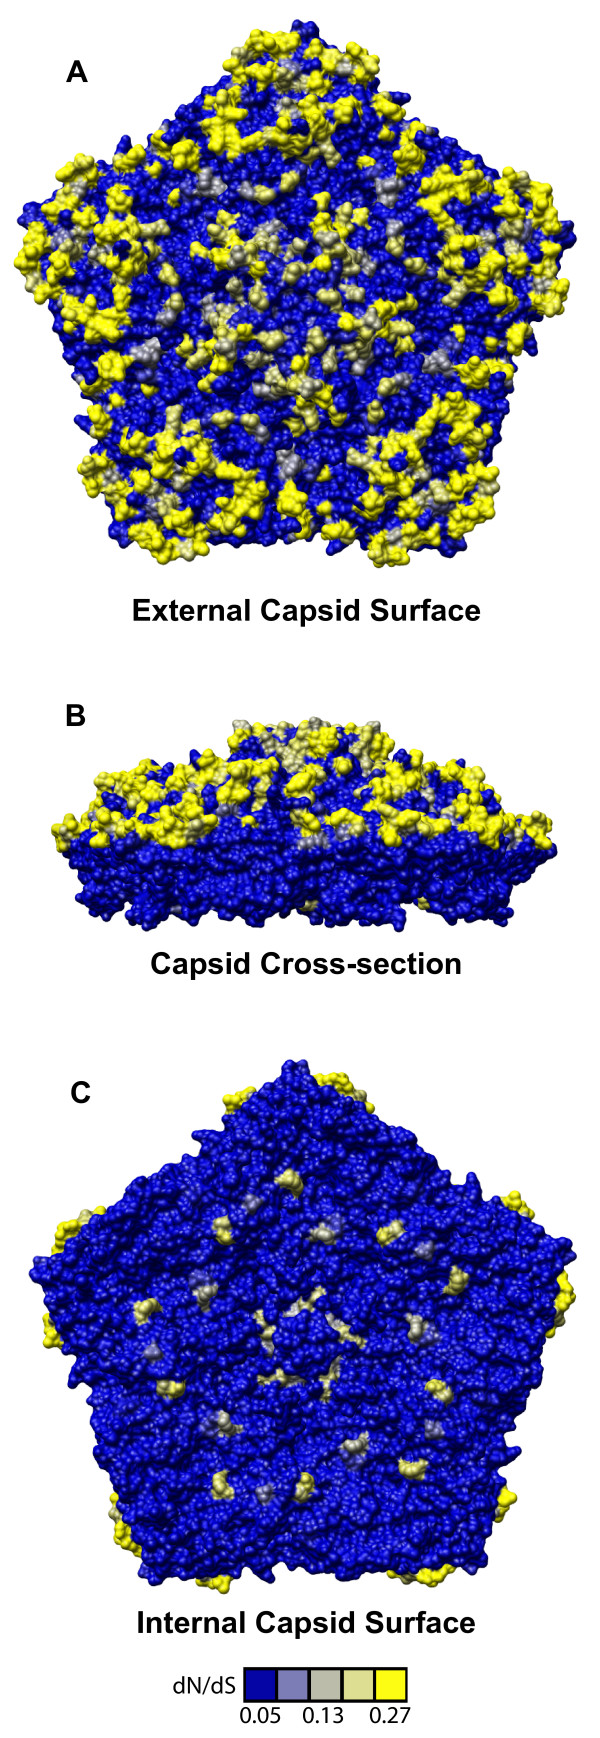
Distribution of selective pressure on the HRV capsid pentamer subunit. Capsid pentamer subunit from the HRV16 viral particle crystal structure (Hadfield, et al., 1997) with residues shaded in yellow according to their corresponding dN/dS values (scale bar below panel C). A. External view. B. Cross-sectional (inside/outside) view. C. Internal face.